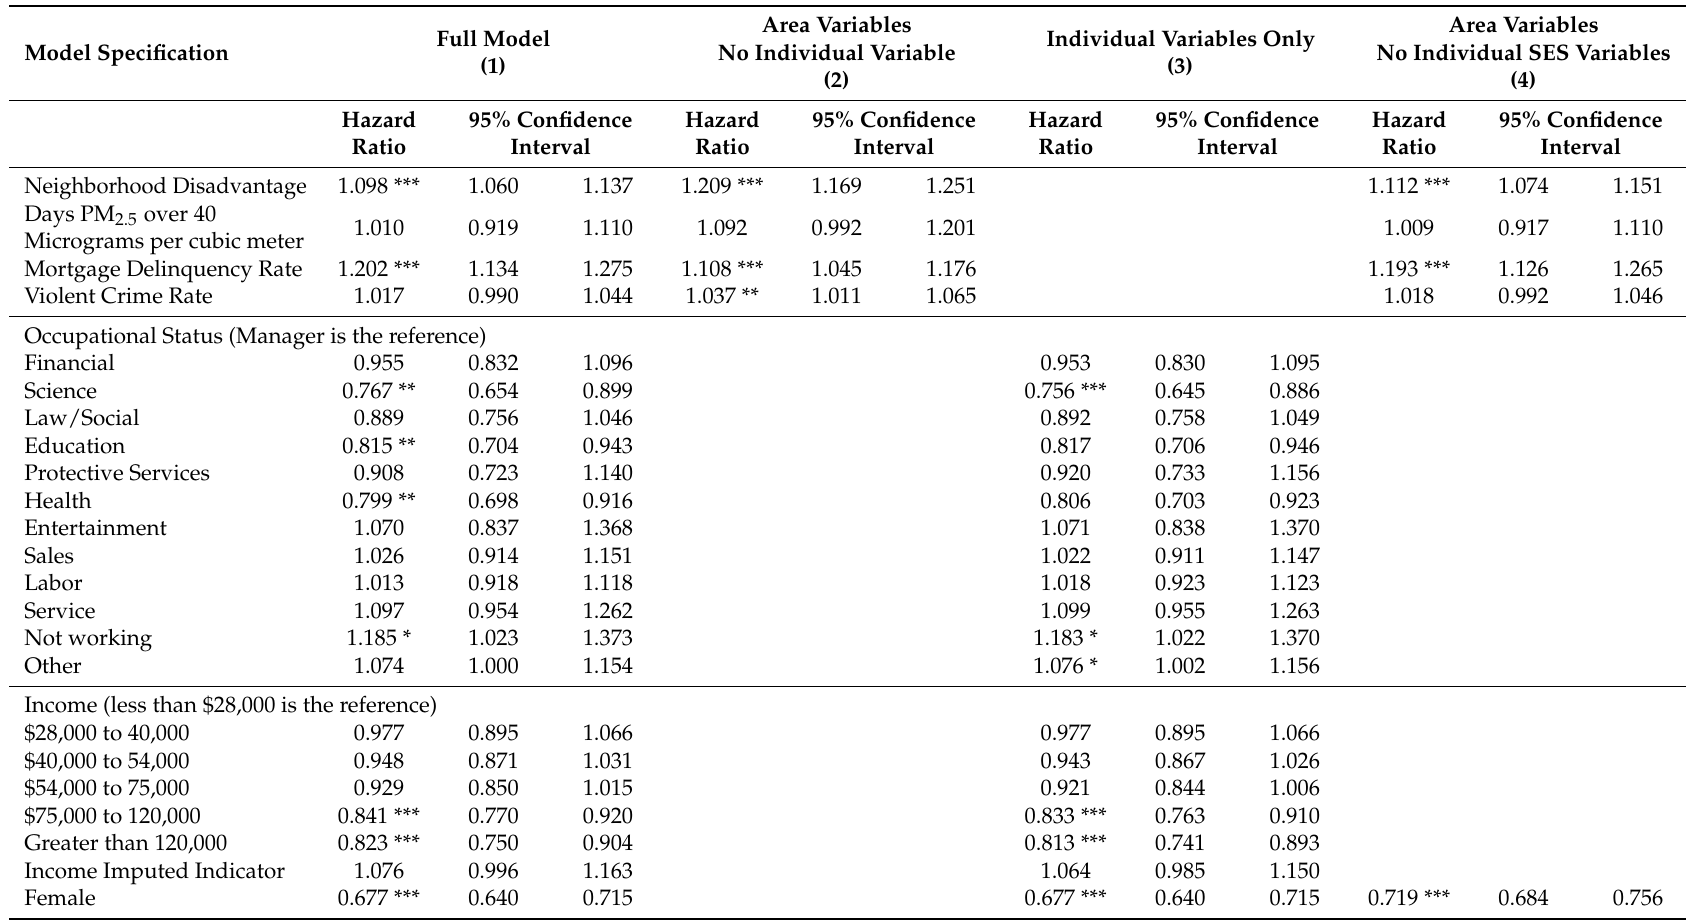
Table 5. Unweighted estimated hazards of dying by area-level factors, individual occupational status, and personal income, all